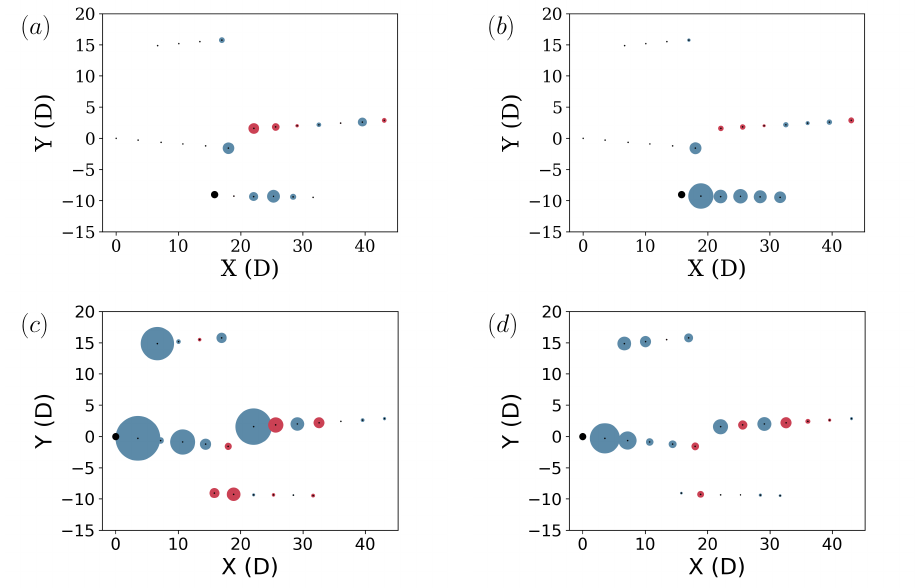
Figure 8. Weight matrix visualization for the C T nonlinearity method with ( a ) Xavier [69] and ( b ) Gaussian initialization for Turbine D1 and ( c ) Xavier and ( d ) Gaussian for Turbine B1. For the C T nonlinearity method in Equation (9), k i , j is visualized. The value of the weight matrices for downstream turbines is plotted with respect to the black dot upstream turbine. The size of the circle represents the magnitude of the weight matrix value and blue represents positive while red is